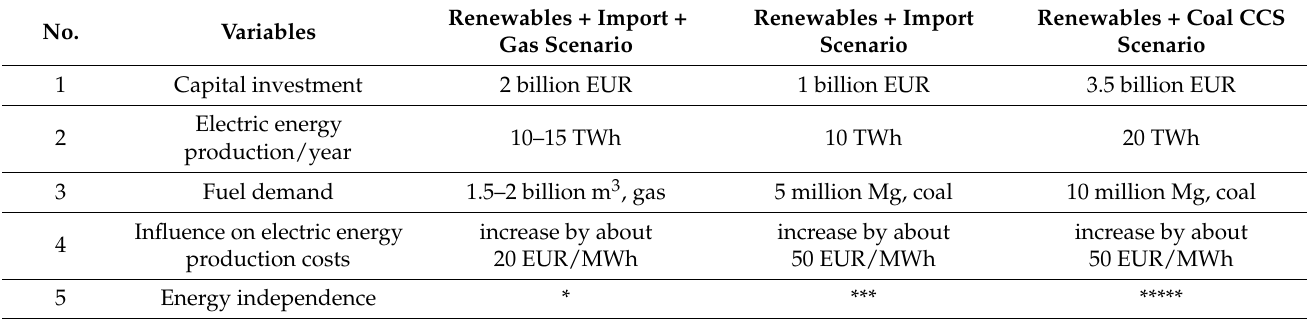
Table 2. Comparison of alternative scenario variables, including the capital investment and the influence on the unit costs of additional electric energy